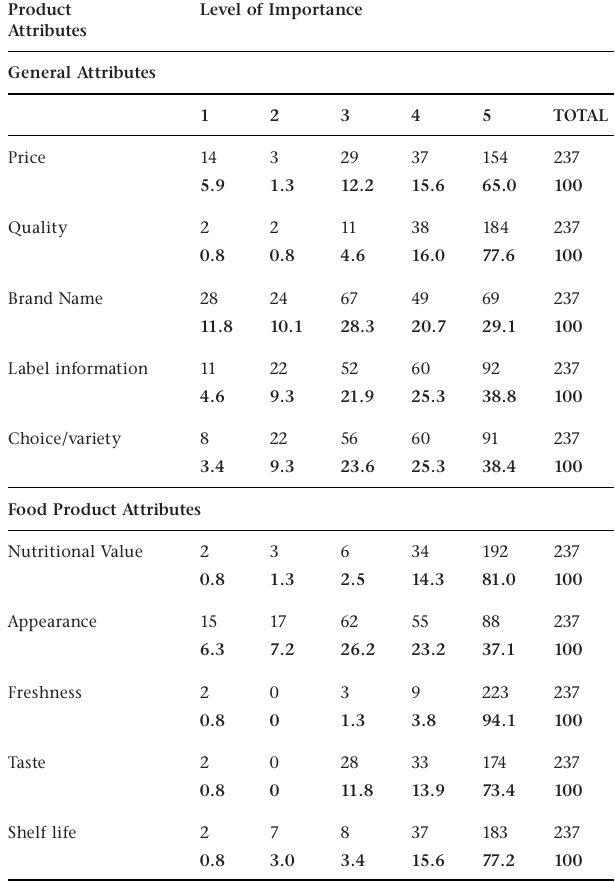
Table 1 reflects that:- (cid:1) The majority of the subjects assigned a rating of 5 to freshness, nutritional value, quality, shelf life, taste and price respectively in descending order of importance.